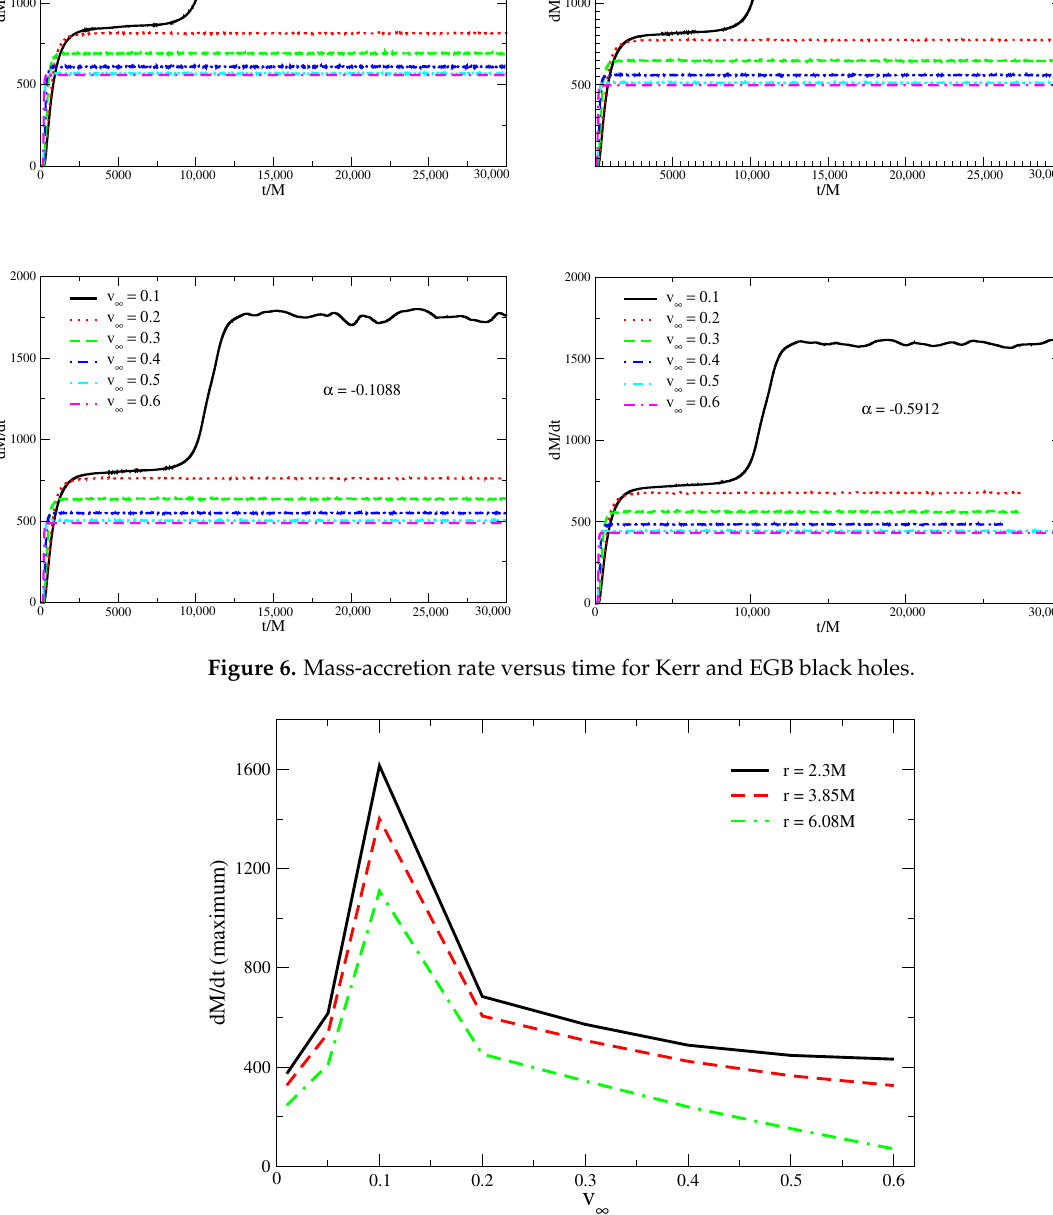
Figure 7. The maximum mass-accretion rate shown as a function of V ∞ at different radial shells for model α = −